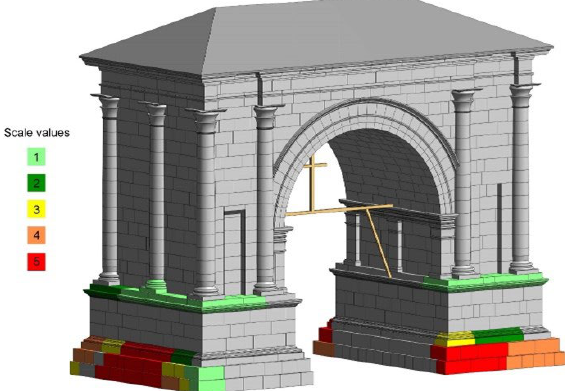
Figure 6: Thematic view about conservation and risk